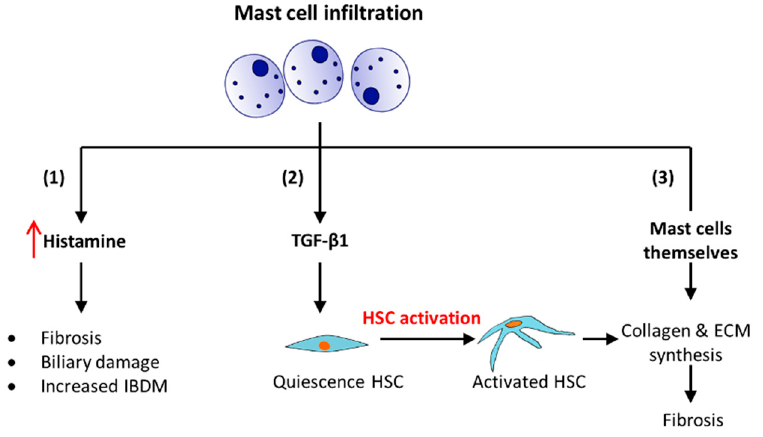
Figure 2. Mast cell infiltration and its role in biliary fibrosis [45].